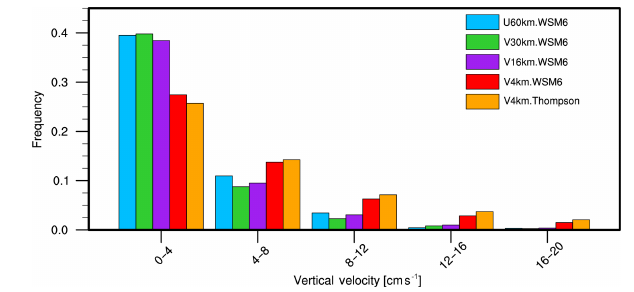
Figure 12. Probability density functions (PDFs) of hourly upward vertical velocity averaged below 700hPa at all the CMA stations during the event over East China (denoted as the black box in Fig. 6) from the MPAS simulations at resolutions of 60, 30, 16, and